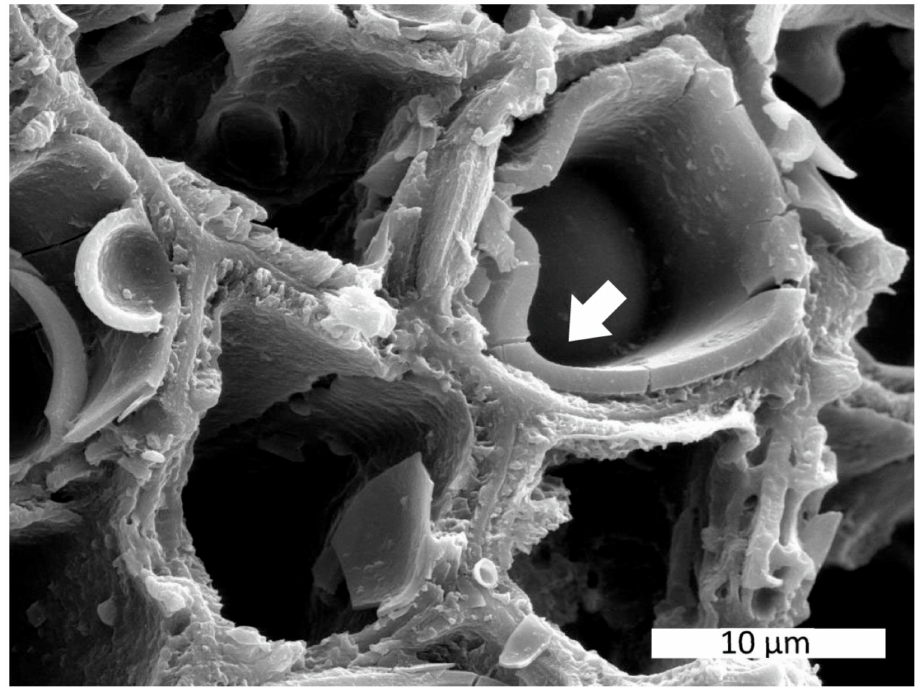
Figure 3. Organic templating is evidenced by silicification of multi-layered cell walls in Late Pliocene fossil wood from Red Hills Lignite Mine, Chocktaw, Missouri, USA. The multilayered architecture of the cell walls remains evident, despite the presence of precipitated silica. A continuous layer of silica on an inner cell surface shown by arrow. Specimen provided by David